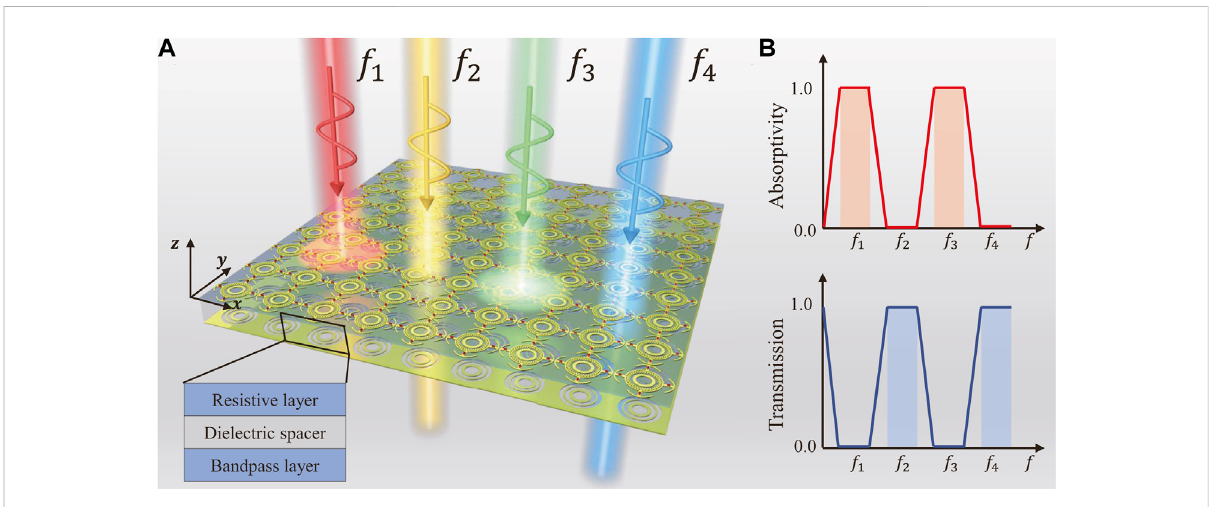
Schematicdiagramofthecascadedmetasurface (A) Thecascadedmetasurfaceiscomposedofaresistivelayer,dielectricspacer,andbandpass layer. (B) Absorptivity and transmission characteristics of an ideal dual-band frequency-selective rasorber.